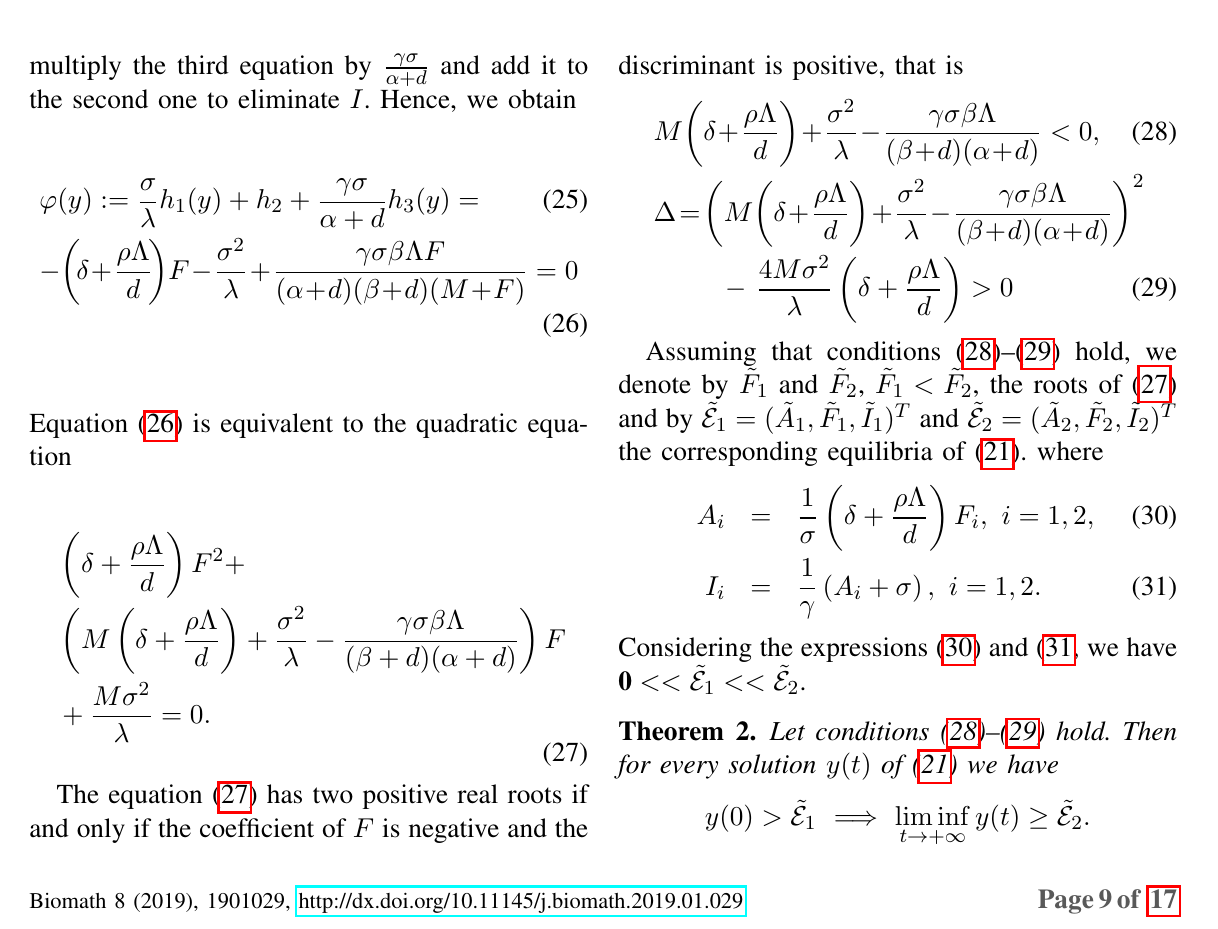
Fig. 4. Illustration of the global stability of the PFE of the host-pathogen model when only condition (a) in Theorem 1